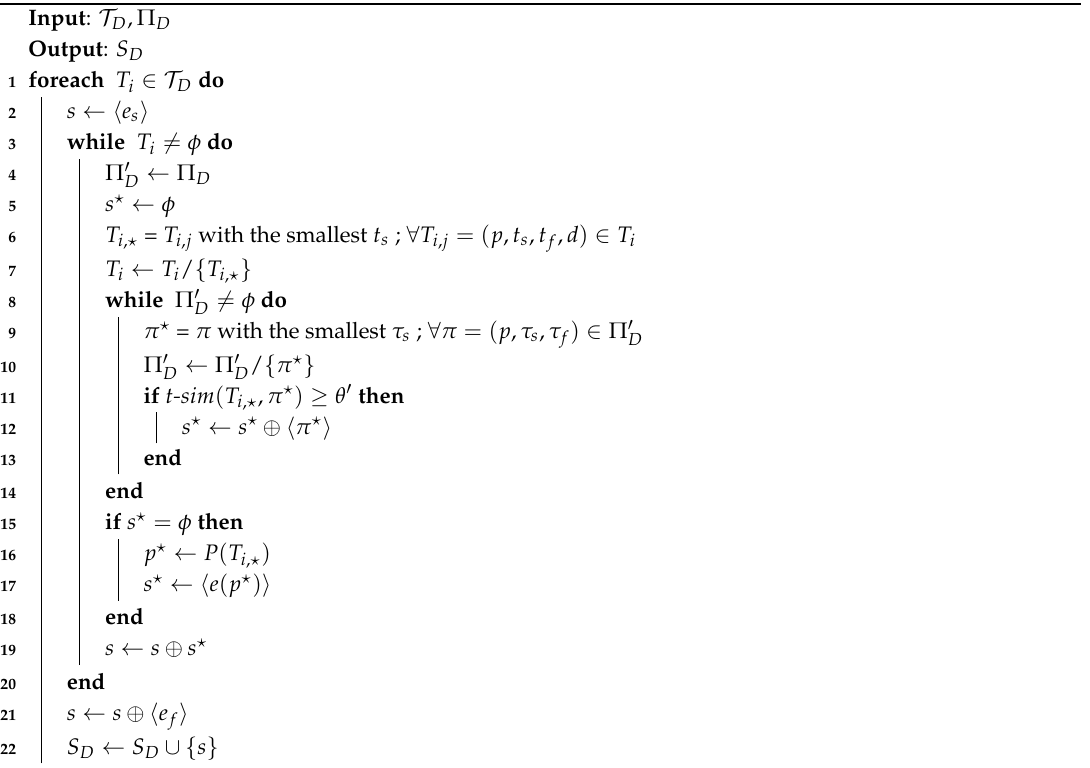
Algorithm 3: Algorithm for STP Trajectory